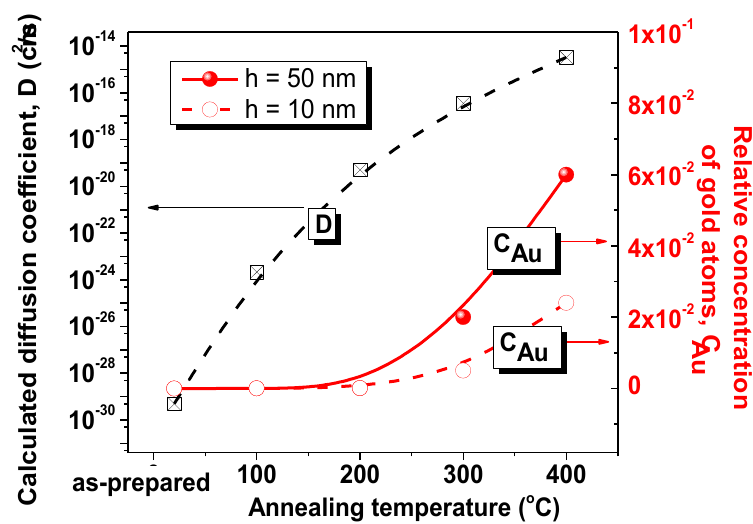
Figure 5. E ff ect of heat treatment temperature on gold atoms di ff usion from a sublayer into the NiFe Figure 5. Effect of heat treatment temperature on gold atoms diffusion from a sublayer into the NiFe film: calculated values of the di ff usion coe ffi cient and relative concentration of gold atoms at a distance film: calculated values of the diffusion coefficient and relative concentration of gold atoms at a of 550 nm (or h = 50 nm) and 590 nm (or h = 10 nm) from the Au / NiFe interface. distance of 550 nm (or h = 50 nm) and 590 nm (or h = 10 nm) from the Au/NiFe interface. − 30 It was found that, at room temperature, D = 4.95 × 10 cm 2 / s. An increase in temperature It was found that, at room temperature, D = 4.95 × 10 −30 cm 2 /s. An increase in temperature to 100